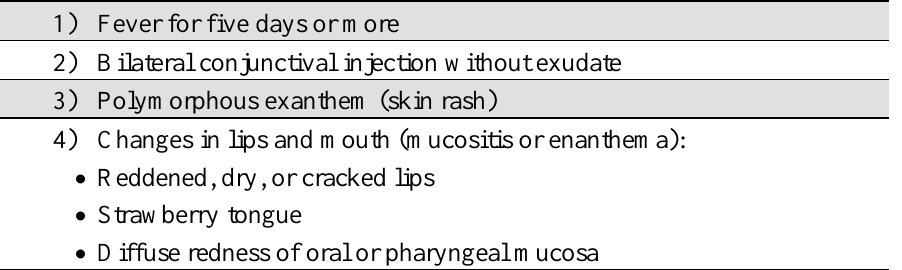
Table 1. List of the classical clinical criteria for the diagnosis of Kawasaki